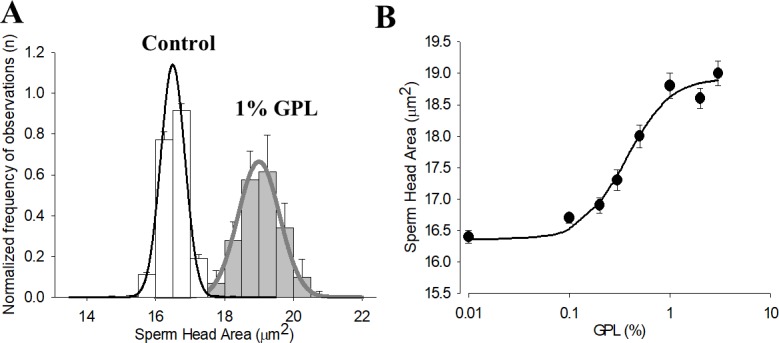
Increase in size of the sperm heads after incubation with sub-μm-sized GPL micelles.(A) Histogram and normal distribution of sperm head size after incubation in control and in 1% GPL mixture. (B) Sperm Head Area and GPL mixture concentration.